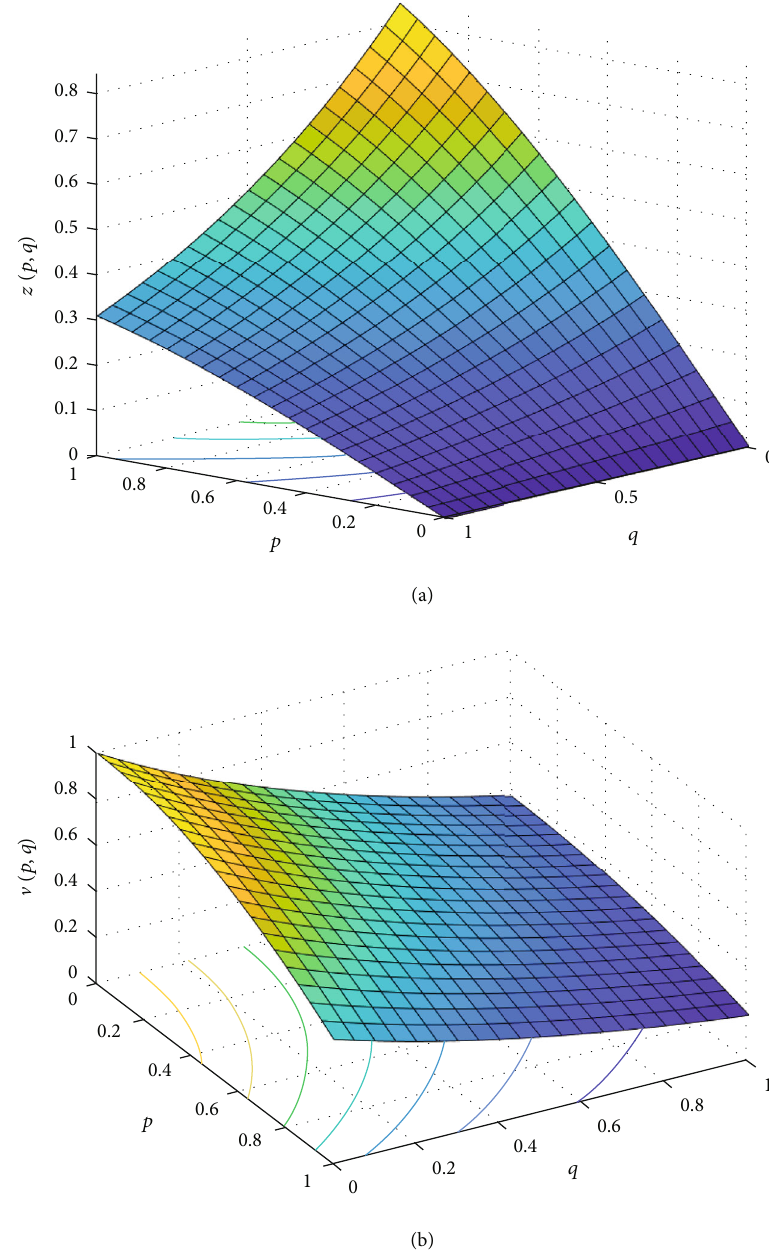
Figure 1: Numerical solution of z ð p , q Þ , v ð p , q Þ with ρ = ω = υ = 1 for Example 7 when m = 6